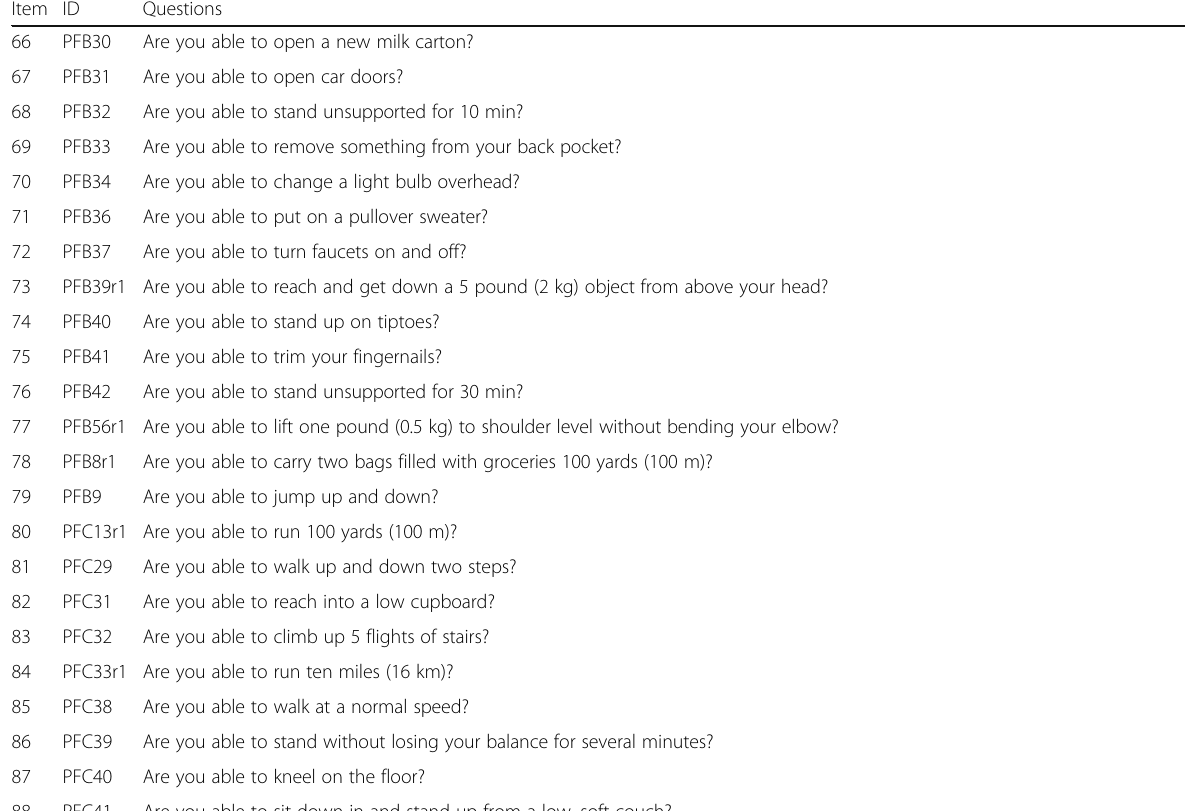
Table 5 PROMIS v1.2 Physical Function item bank